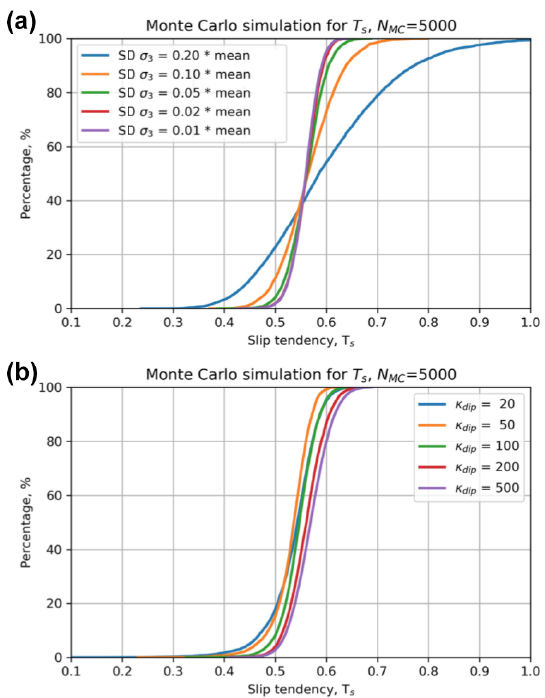
Figure 5. Output from Monte Carlo sensitivity tests for slip ten- dency ( T s ). (a) Effect of variation in standard deviation of the least principal stress, σ 3 . (b) Effect of variation in dispersion ( κ parame- ter of the Von Mises distribution) of fault